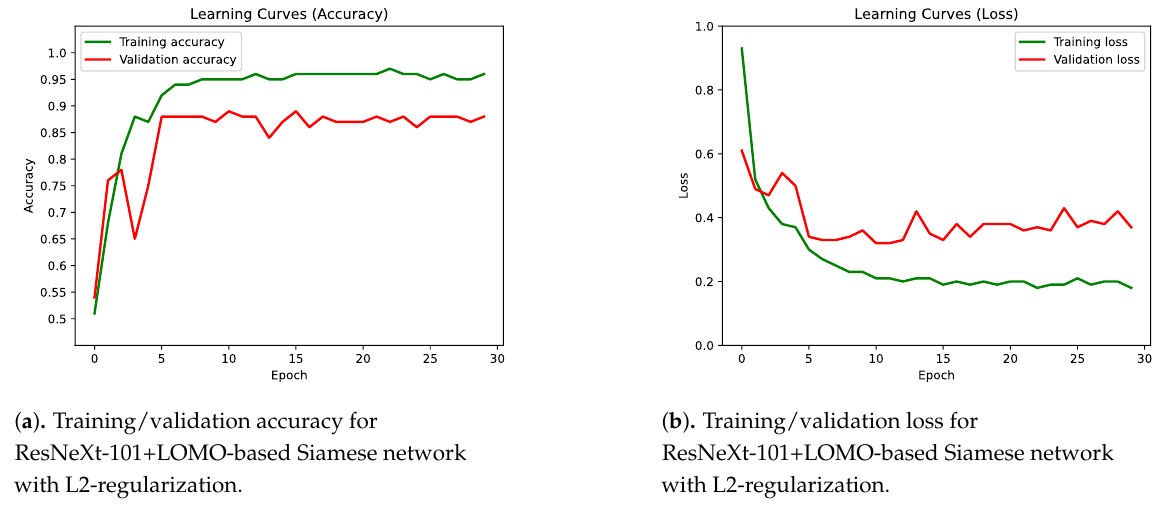
Figure 15. Siamese network training with ResNeXt-101+LOMO and